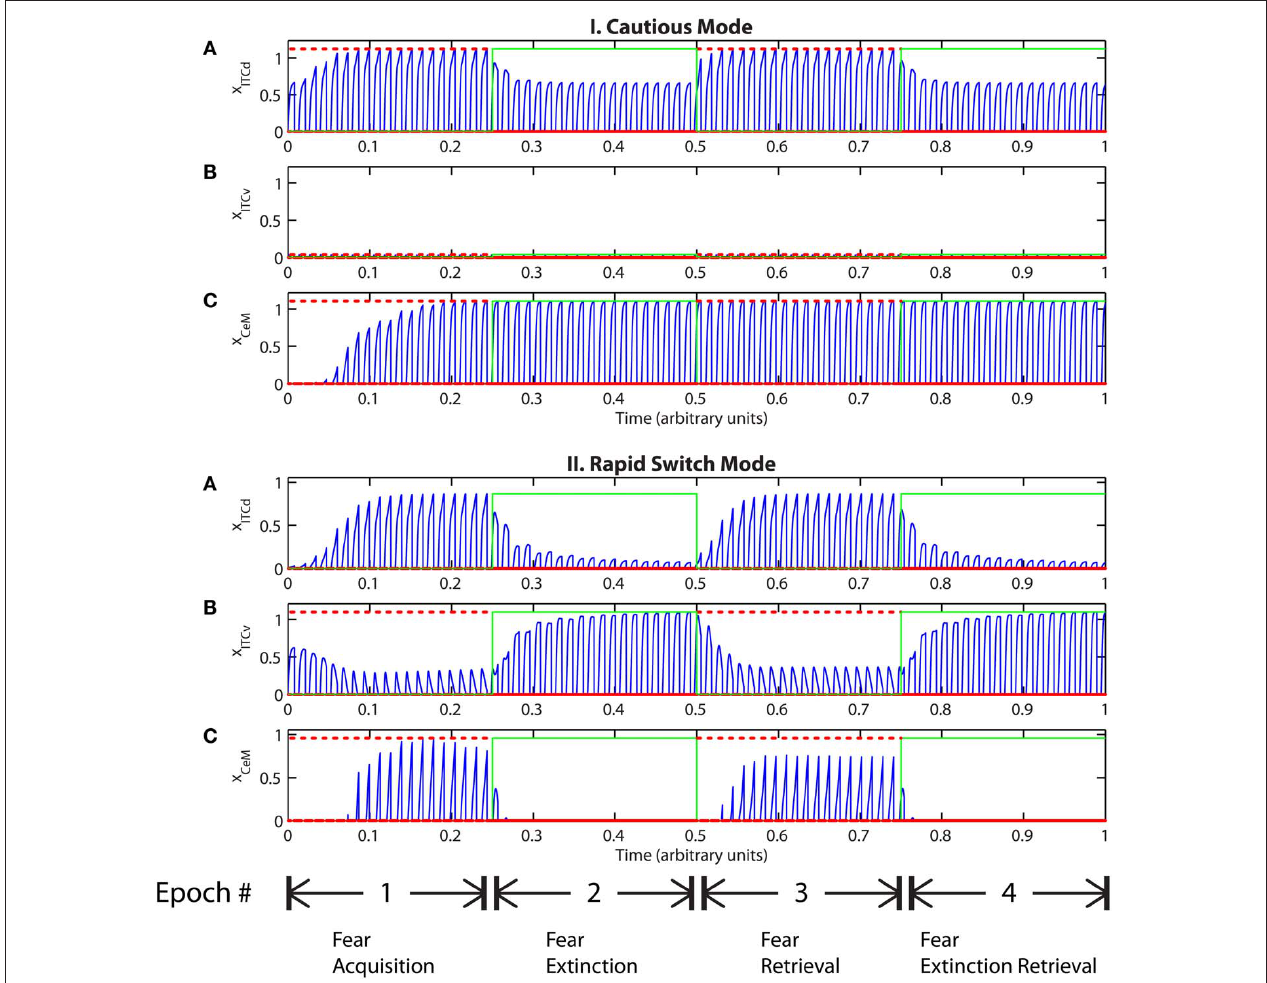
FIGURE 7 | (I) Time evolution of model cell activities during “cautious” mode (when ITCd activation is much higher than ITCv activation): the system is biased to prevent extinction. (Parameters: strength of inhibition f I = 3 . 0; input from IL to ITCd E ILd = 5; input from IL to ITCv E ILv = 2). (II) Time evolution of model cell activities during “rapid switch” mode (when ITCv activation is much higher than ITCd activation): the system is biased to enhance extinction. (Parameters: strength of inhibition f I = 3 . 0;